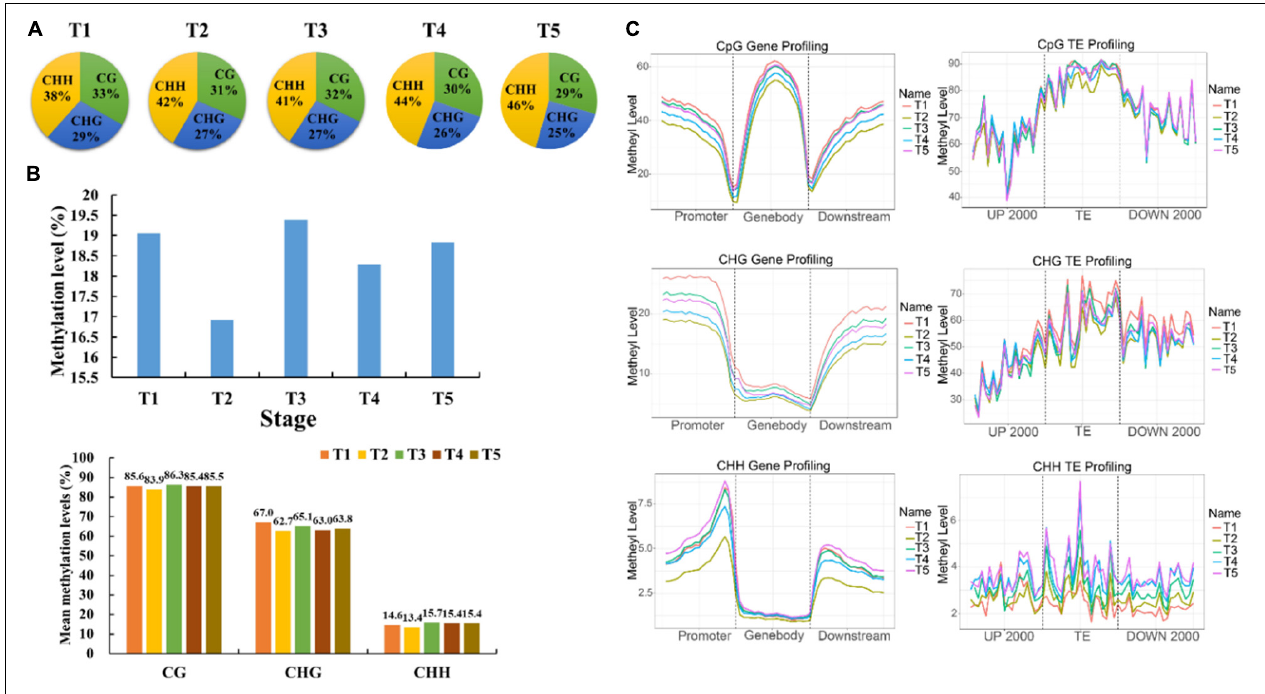
FIGURE 2 | Characteristics of DNA methylation in foxtail millet. (A) Relative proportions of mCs in three sequence contexts (CG, CHG, and CHH) in foxtail millet. (B) mC, mCG, mCHG, and mCHH methylation levels from 7 to 35 DAA. (C) Methylation levels (%) of CG, CHG, and CHH among gene/TE bodies and their 2-kb upstream and downstream regions at different stages.